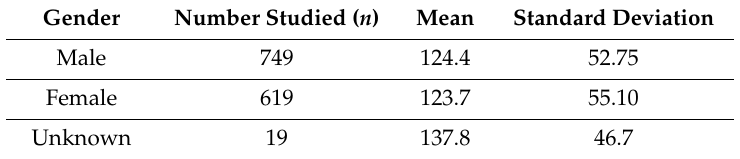
Figure5. ComparisonoftT 4 concentrationsbetweenmaleandfemalenewborns. Circlesrepresentoutliers. Figure 5. Comparison of tT 4 concentrations between male and female newborns. Circles represent outliers. Table 5. Comparison of tT 4 concentrations between male and female Table 5. Comparison of tT 4 concentrations between male and female newborns.